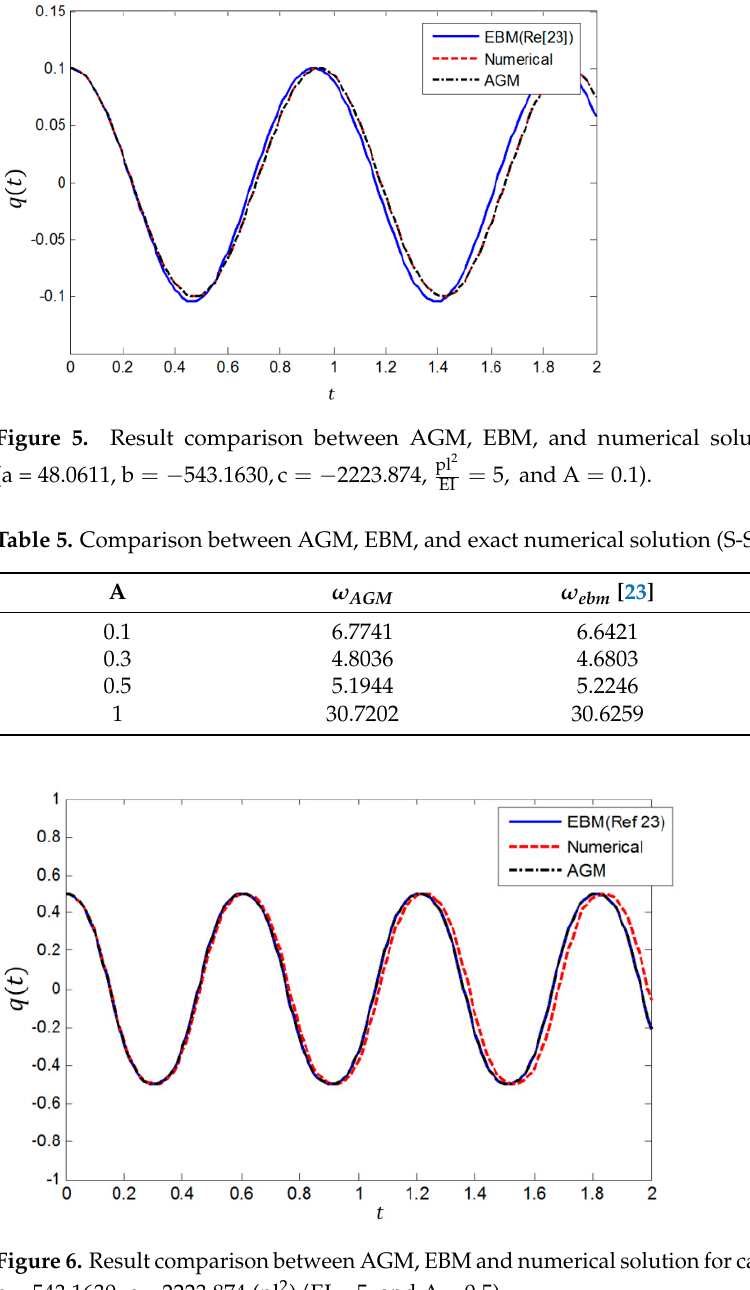
Figure 6. Result comparison between AGM, EBM and numerical solution for case study 3 (a = 48.0611, b = 543.1630, c = 2223.874 (pl^2)/EI = 5, and A = 0.5).